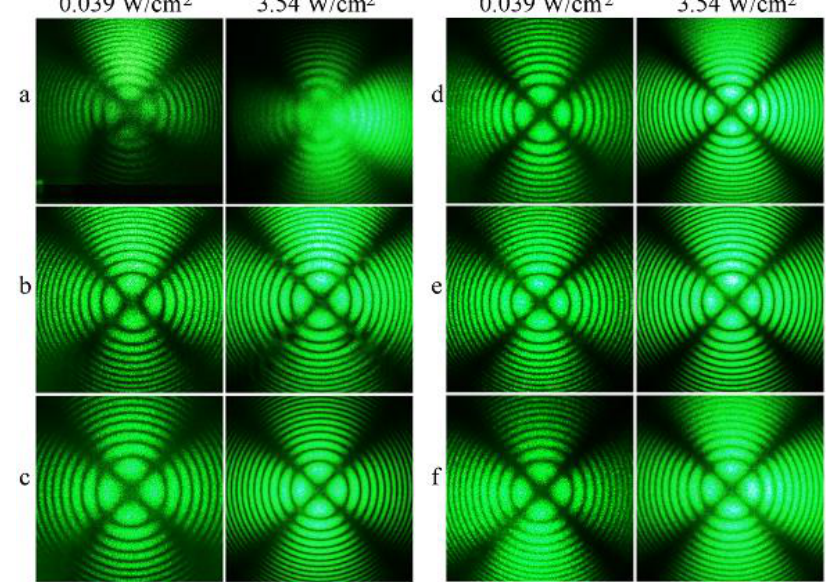
Figure 16. Conoscopic patterns of crystals: ( a ) SLN; ( b ) SLN(K 2 O); ( c ) LiNbO 3 :Zn (4.5 mol.% ZnO); ( d ) LiNbO 3 :Mg:Fe (5.01; 0.005); ( e ) LiNbO 3 :Mg (5.1, solid phase doping); ( f ) LiNbO 3 :Mg (5.3, homogeneous doping). λ = 532 nm. p = 0.039 and 3.54 W/cm 2 . The figure is reproduced with the permission of Pleiades Publishing, Ltd. from the paper Inorg. Mater.: Appl. Res. 2016, V. 7, P. 170–176. doi: 10.1134/S2075113316020209.